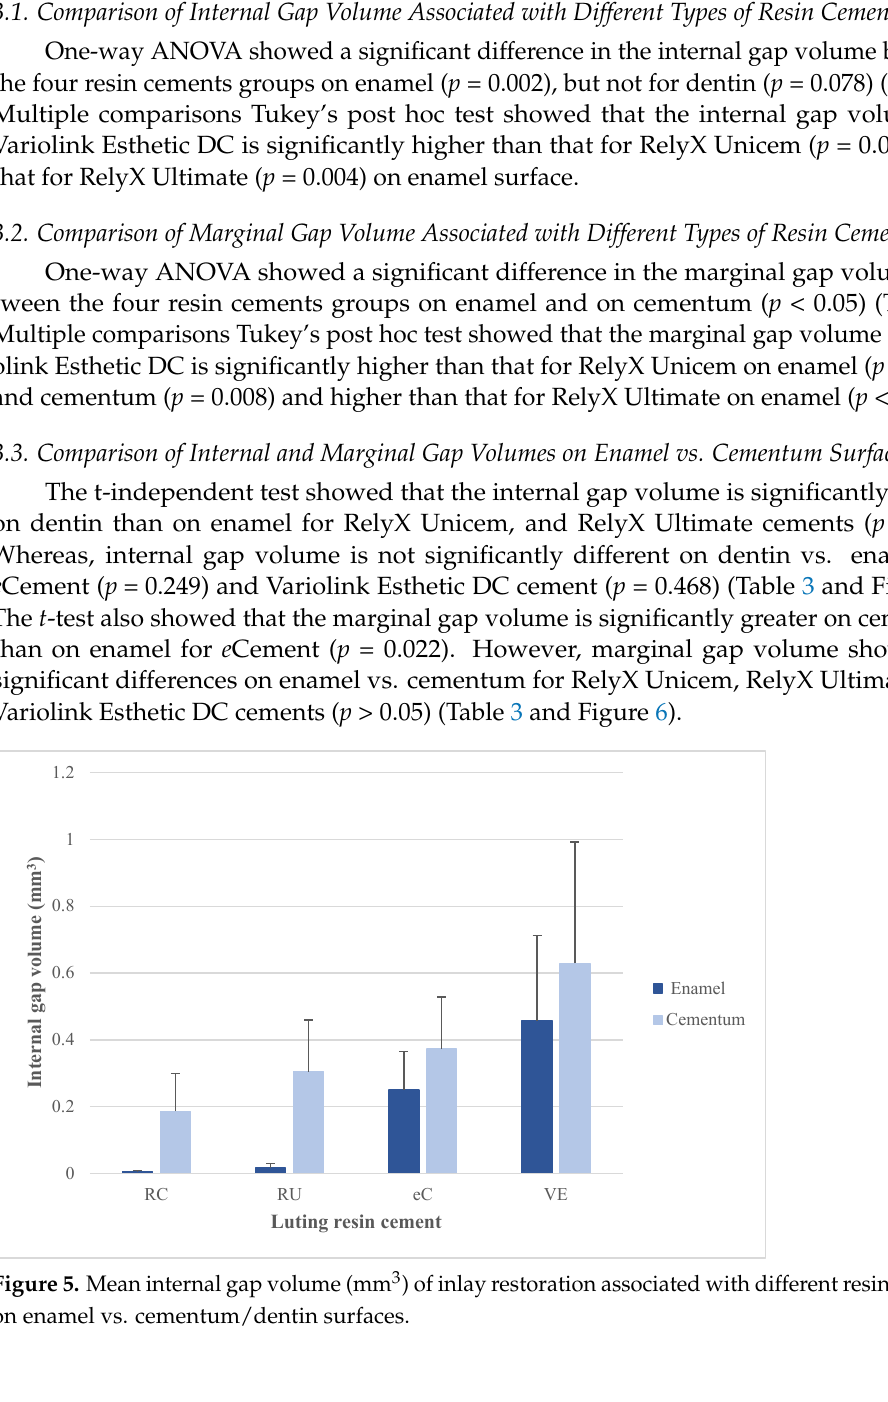
Figure 4. Micro-CT images internal and marginal gap at the gingival floor of a Class II Lava Ultimate inlay luted with Variolink esthetic DC resin cement on ( a ) enamel and ( b ) cementum/dentin. Adhesive layer contains: solid arrow, silver deposits; dotted arrow, void.